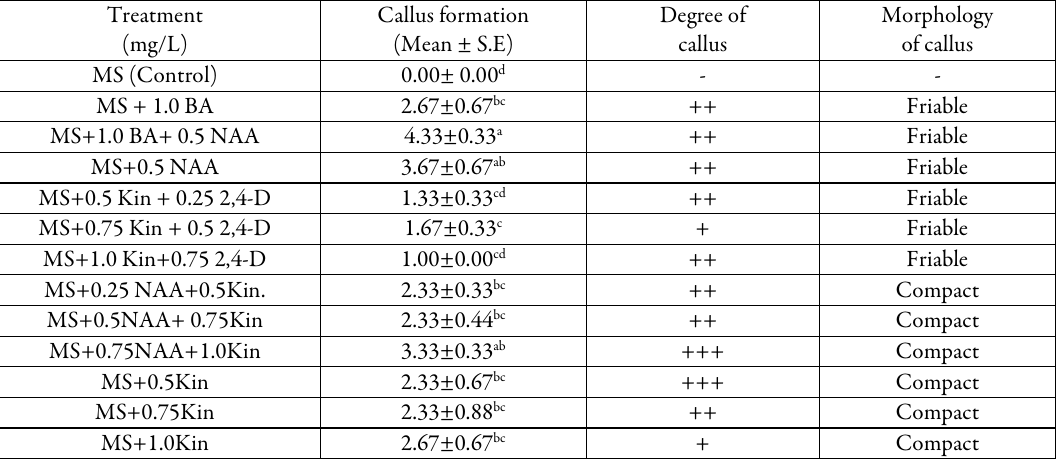
Table 3. Effect of different concentrations of auxins (NAA and 2, 4-D) and cytokinins (BA and kinetins) on callus formation from stem explants of in vitro germinated P. erosus